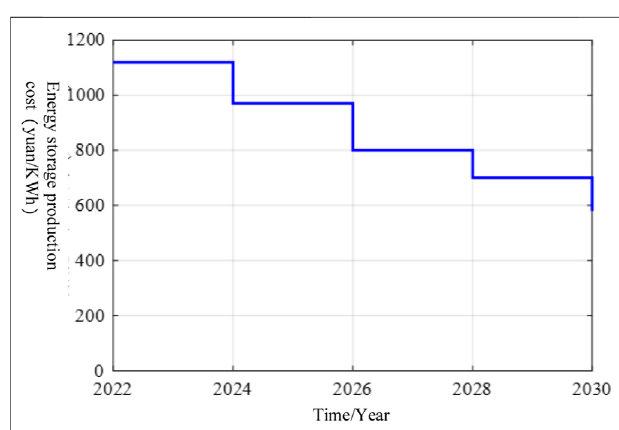
FIGURE 7 | Change trend of investment cost of the retired power